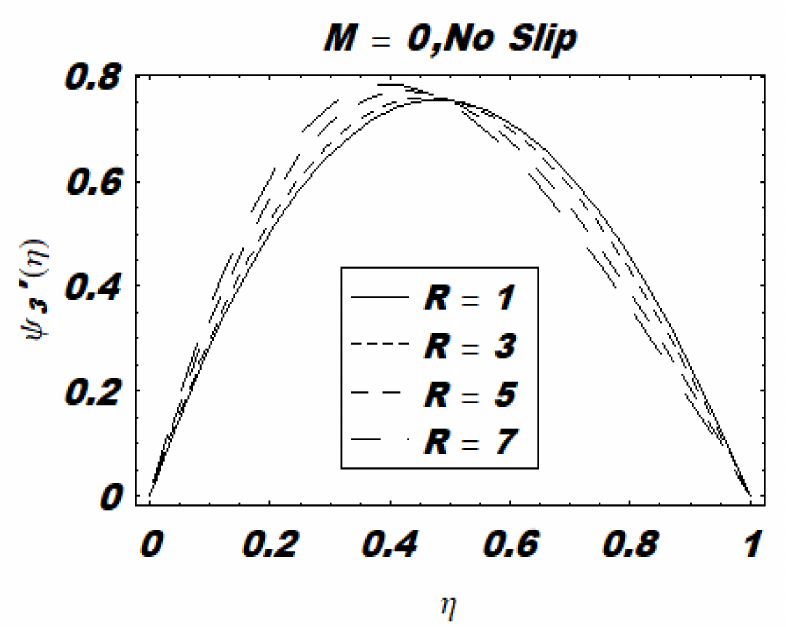
Figure 19. Similarity function ψ /